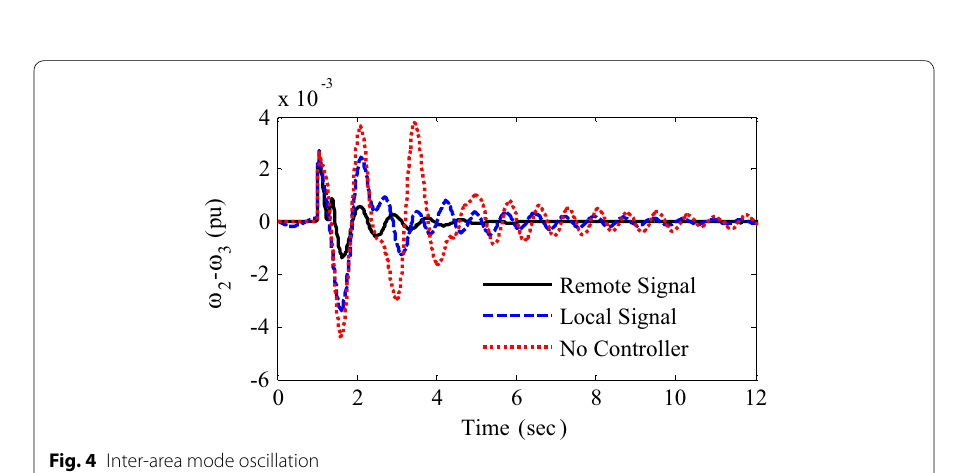
Fig. 3 Local mode oscillation